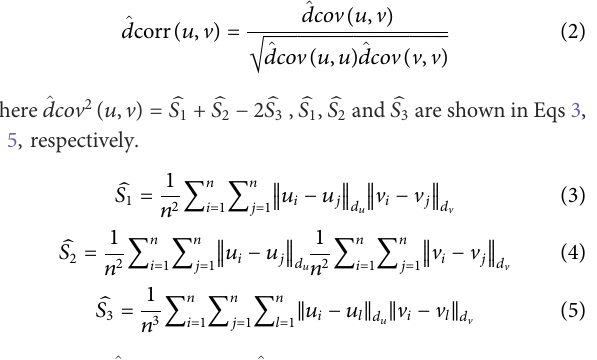
WGCNA (Langfelder and Horvath, 2008). The code of the KISL algorithm are available online at https://github.com/Mowonhoo/ KISL.git.